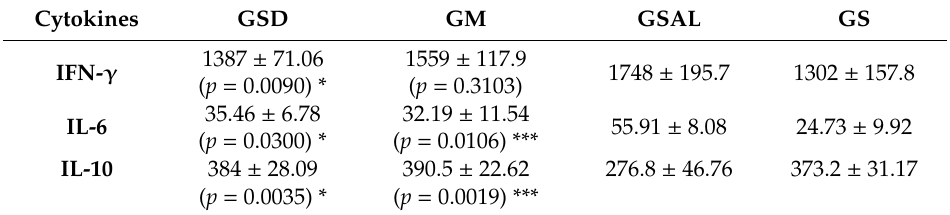
Table 3. E ff ect of crude extract of S. dulcis on cytokines. Table 3. Effect of crude extract of S. dulcis on cytokines.